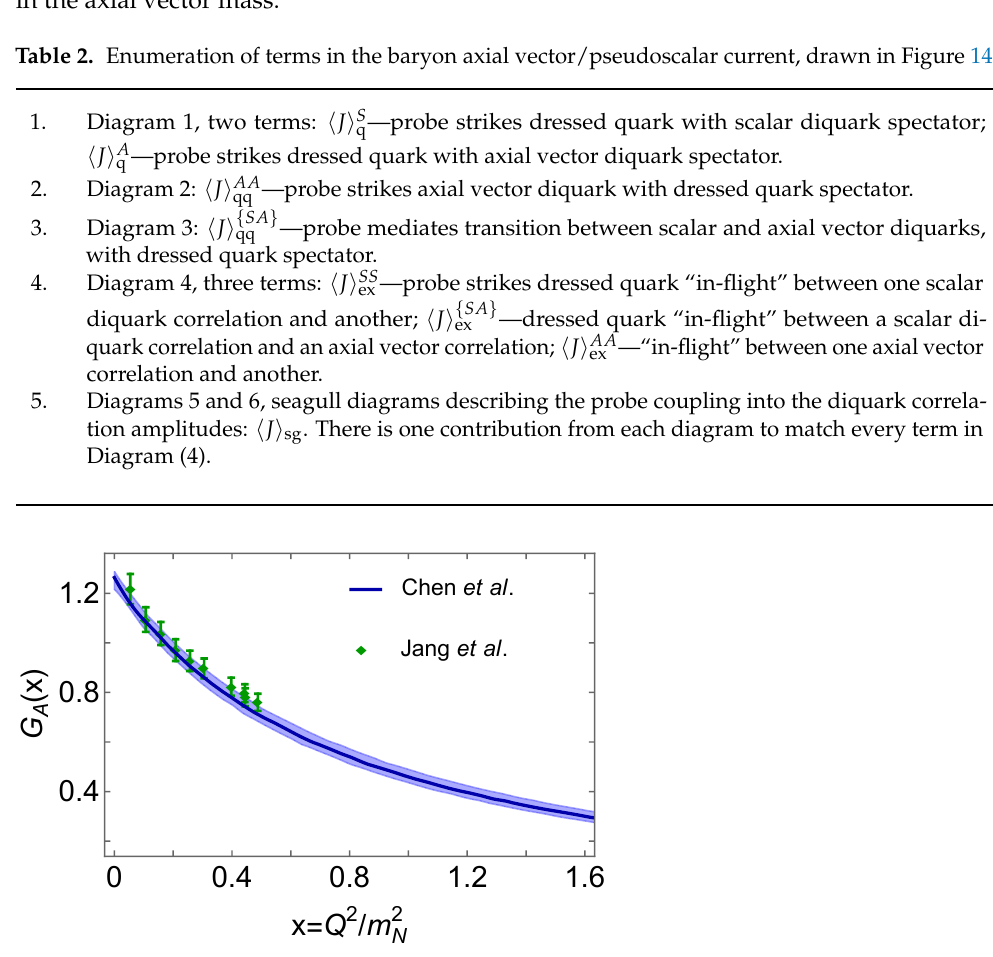
Figure 15. Predicted result for G A ( x ) in Reference[275] (Chen et al.) (blue curve within lighter blue uncertainty band), compared with lQCD results from Reference[347] (Jang et al.) (green) diamonds. With respect to the CSM central results, this comparison may be quantified by reporting the mean- χ 2 value, which is